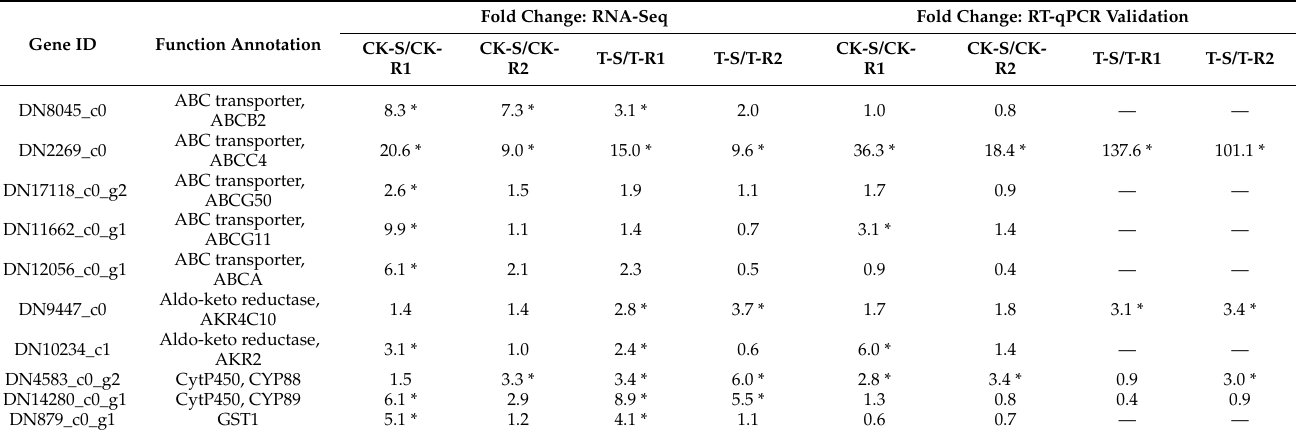
Table 3. Selection of up-regulated unigenes annotated and related to glyphosate resistance in Eleusine indica biotypes by RNA-Seq and RT-qPCR.